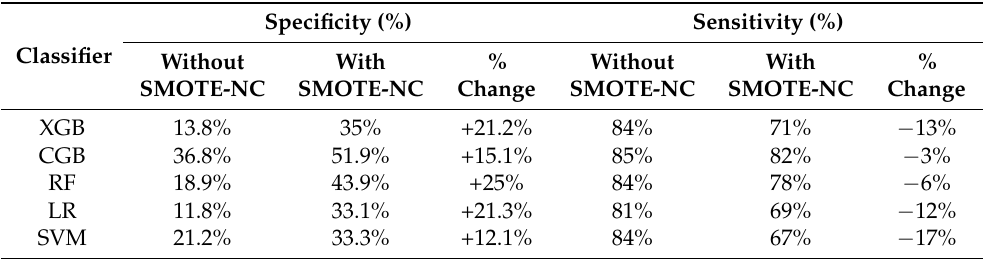
Table 6. Performance (specificity and sensitivity) of the 5 classifiers on diabetes-prediction balanced and unbalanced